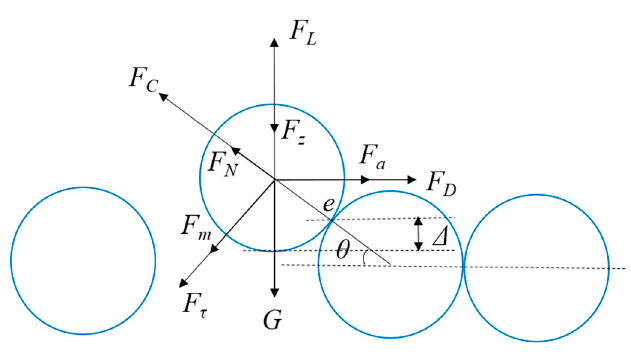
Figure 13. Sediment particle force model.